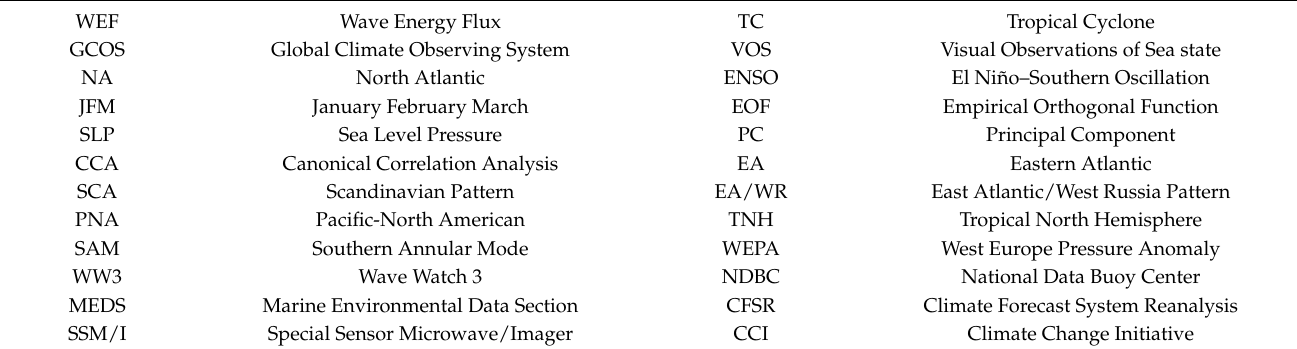
Table 1. Glossary of acronyms used in this